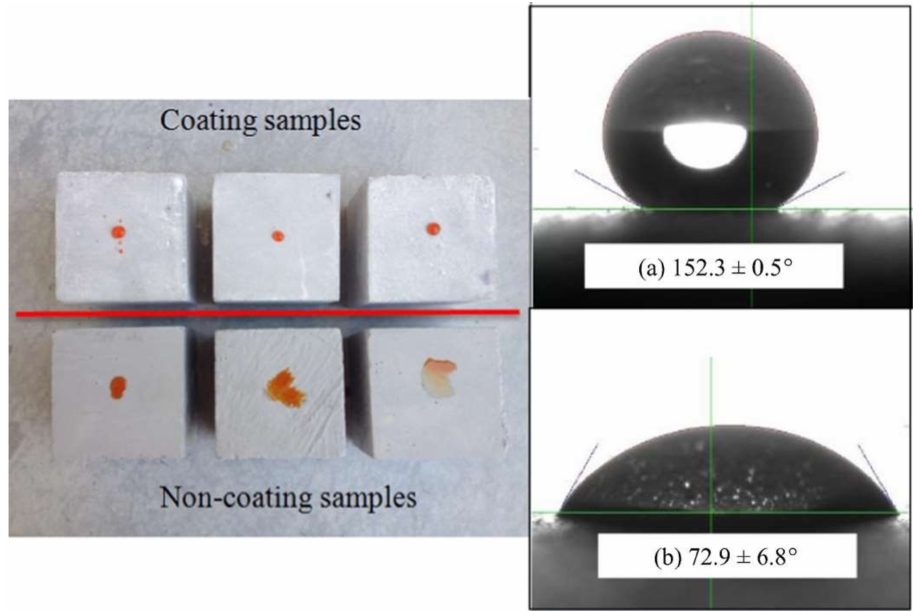
Figure 4. Image of the contact angle measured on concrete with superhydrophobic rice husk ash coating ( a ) and on concrete without any coating ( b ). Reprinted from [59], with permission from Elsevier (November,